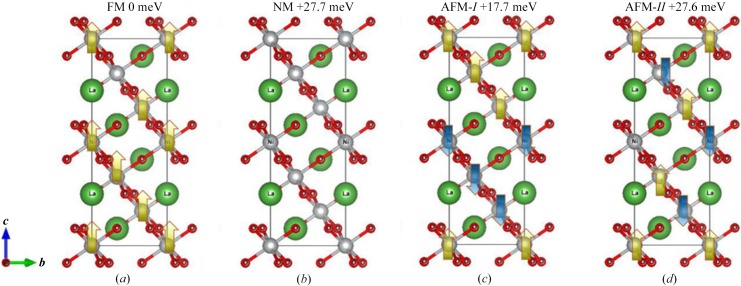
Crystal structures of LaNiO3; the different magnetic structures including (a) FM, (b) NM, (c) AFM-I and (d) AFM-II are taken into consideration.